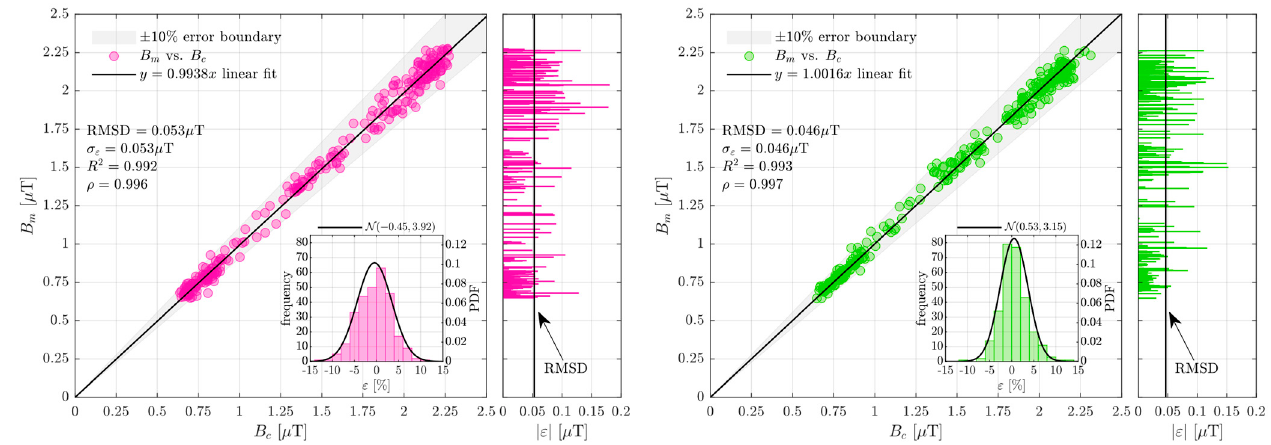
Figure 8. Proposed technique performance assessment for points P1 ( left ) and P2 ( right ). As easily noticeable in Figures 9 and 10, the instantaneous measured field (solid lines) at points P1 and P2 is well bounded by the calculated field 95% confidence interval (filled areas). The same conclusions can be drawn from the instantaneous residuals absolute value (solid red lines) adequately confined by the 95% confidence interval sideband (dash- dot lines). Furthermore, it can be derived that the showed confidence interval calculated using Equation (16) does not appreciably differ from the single value that σ ε could have provided. Indeed, traces in Figures 9 and 10 settle around 107 nT and 96 nT while the more straightforward calculation 1.96· σ ε produces 104 nT and 90 nT respectively for points P1 and P2. Figure 9. Position P1 measured field evolution over the 24 h (solid pink like) and its predicted 95% confidence interval (filled area). The absolute value of the residuals (red trace) is well confined by the confidence interval sideband (dash-dot line).